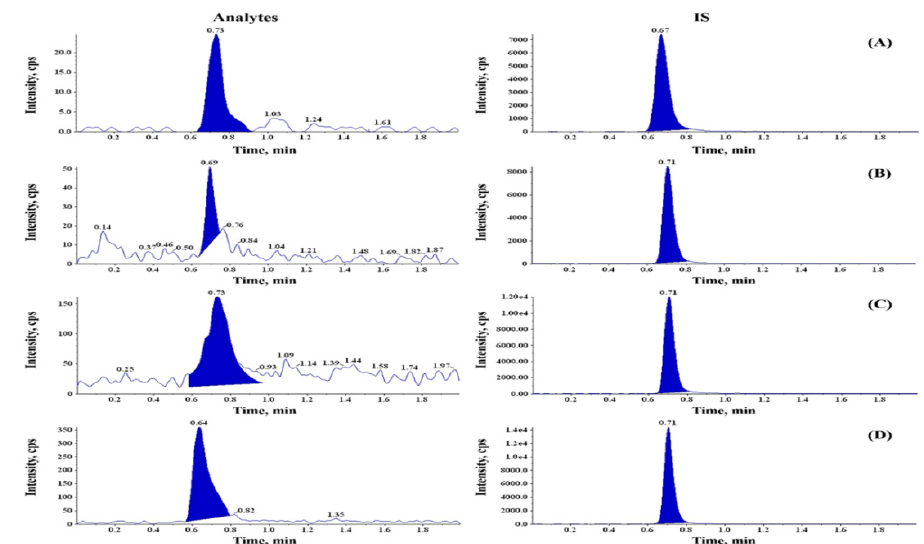
Figure 3. Separation of the benzo[a]pyrene and its metabolites in serum of rats. The analyses of the benzo[a]pyrene (BaP) metabolites were detected using liquid chromatography tandem mass spectrometry (LC/MS/MS). Mobile phase; D.W (0.1% formic acid): Acetonitrile (0.1% formic acid) = 2:98, calibration curve: R = 0.99, with gradient program (2:98, D.W, containing 0.1% formic acid: Acetonitrile containing 1% formic acid) as a mobile phase. Chromatographic profiles as almost baseline without the elution of BaP and metabolites, probably due to retaining the BaP and its metabolites on the resin under such conditions. Left panels indicated the typical LC/MS/MS chromatogram of ( A ) BaP; ( B ) 3-OH BaP; ( C ) 7-OH BaP; ( D ) BaP-diolepoxide (BPDE). Right panels indicated the typical LC/MS/MS chromatograms of internal standard (cryptotanshinone).